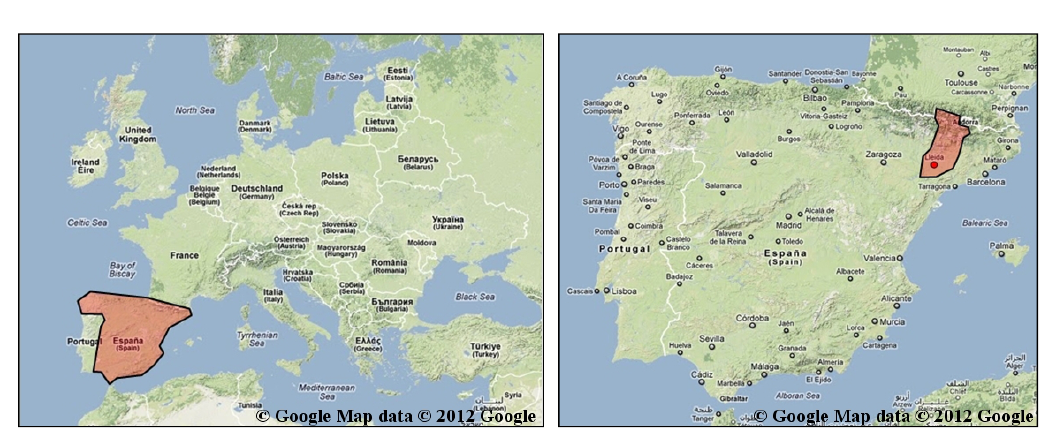
Figure 2. Location of Lleida within Spain (Courtesy of